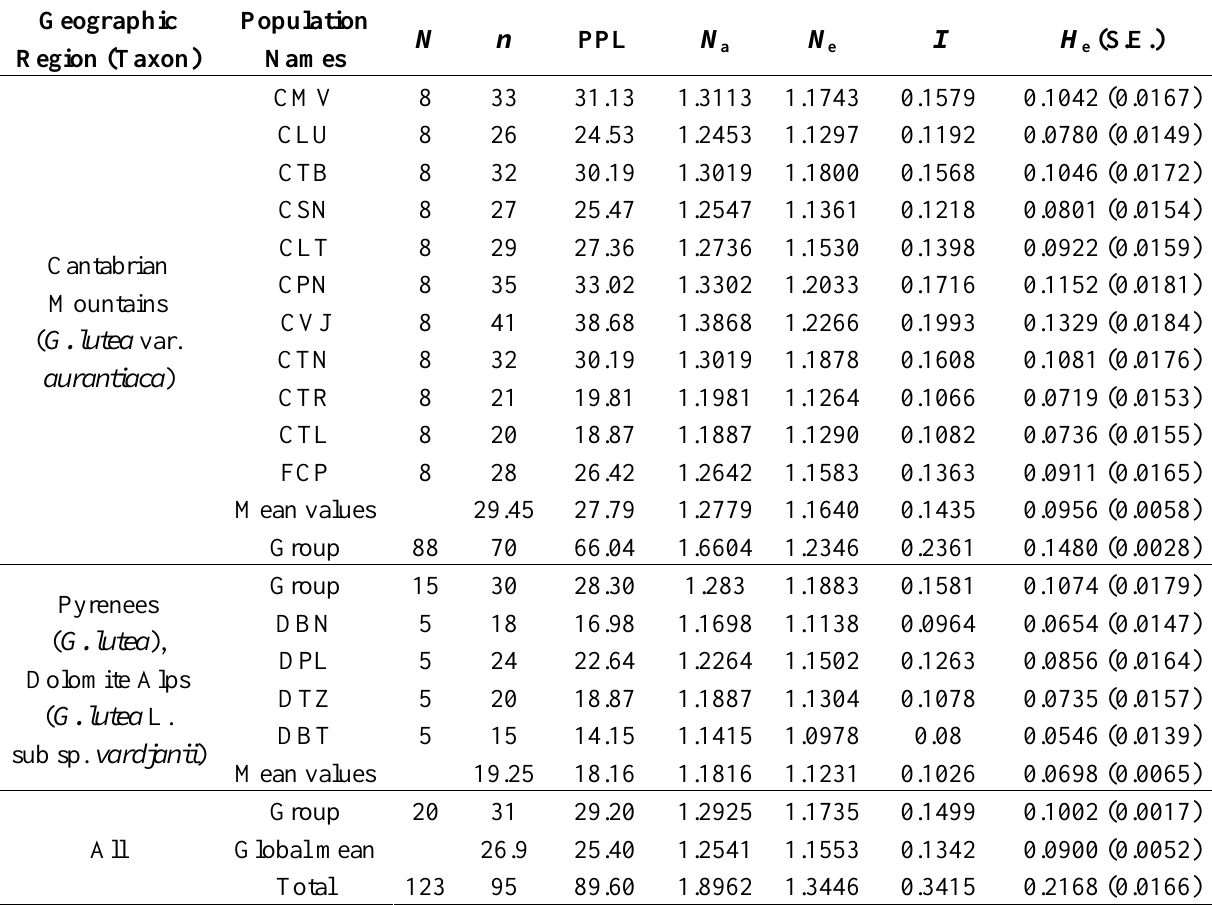
Table 1. Genetic variation in populations of Gentiana lutea ( G. lutea ) detected by inter-simple sequence repeat (ISSR) markers.